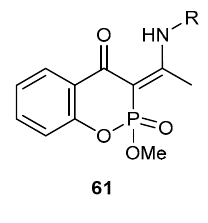
Figure 9. Another example of compounds 61 .